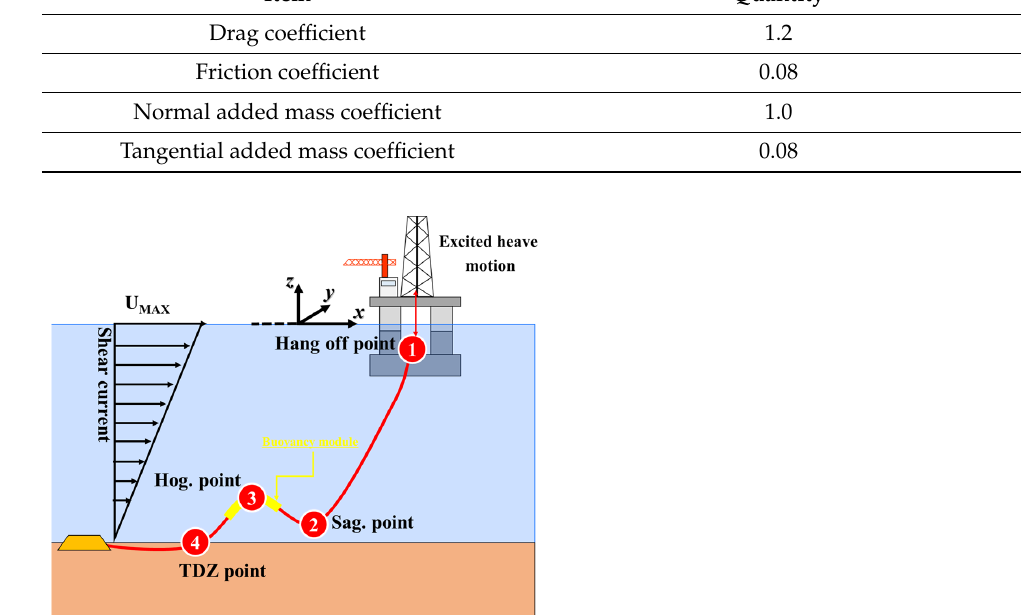
Table 4. Hydrodynamic coefficients for SLWR analysis.